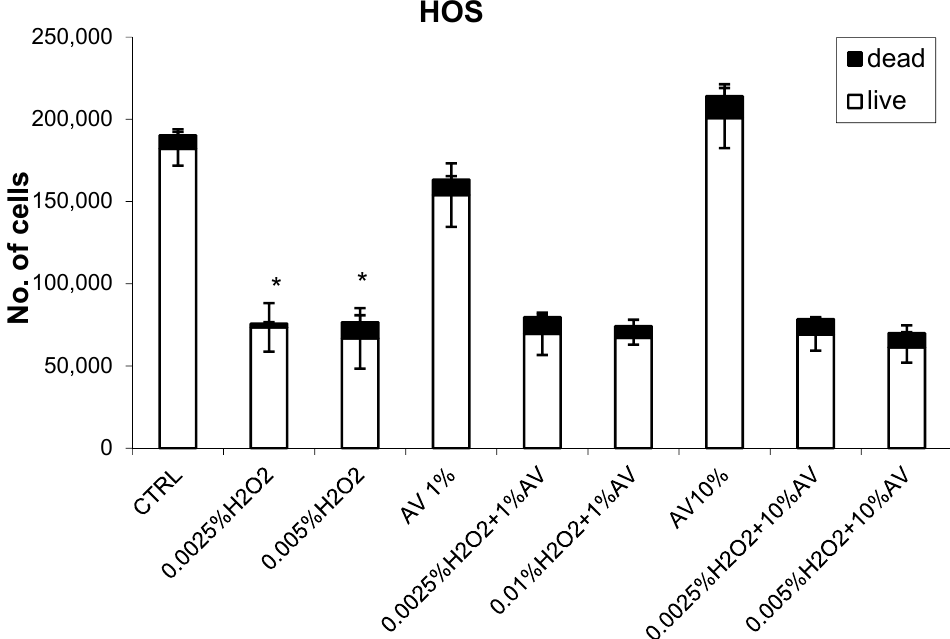
Figure 5. The effects of AV extract (1 or 10%) on the human osteosarcoma (HOS) cells with respect to H 2 O 2 treatment (0.0025% or 0.05%). The cell count values (viability determined using Trypan blue) were obtained 24 h after treatment (H 2 O 2 followed by AV extract 1 h later) and are given as mean values for triplicates. * significant difference to untreated control.